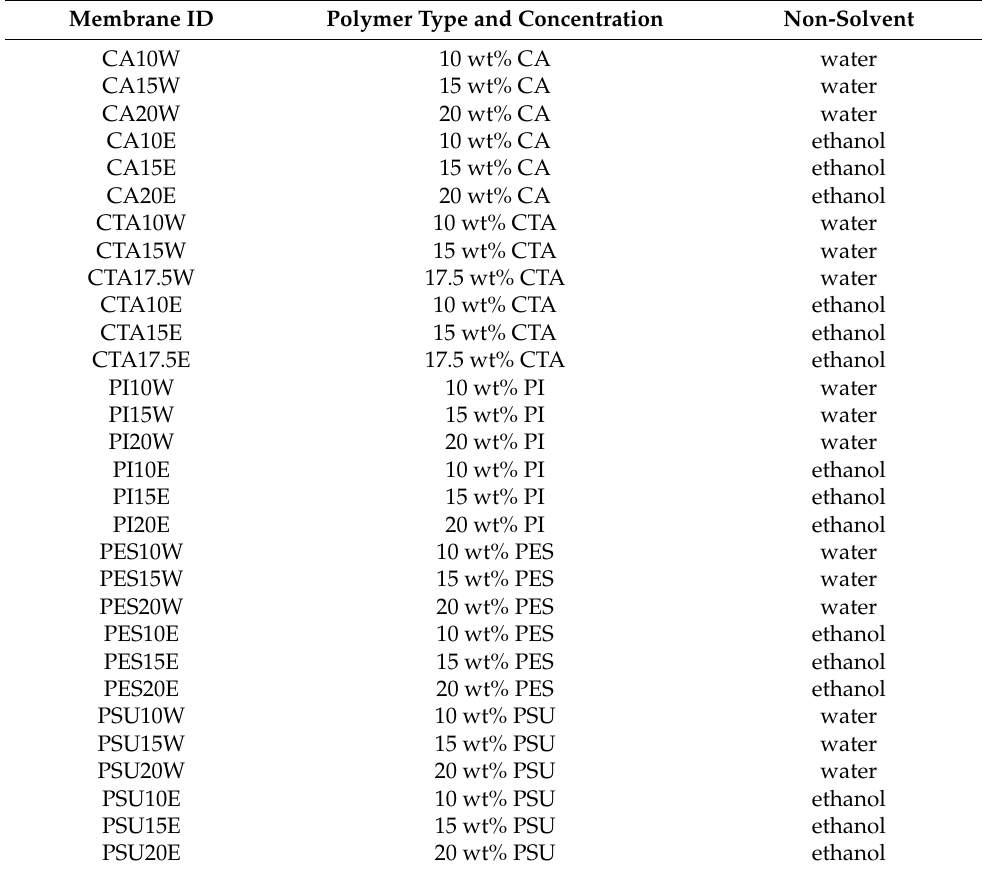
Table 2. Concentration of polymer in the casting solutions, the applied non-solvent and the membrane ID. γ -Valerolactone (GVL) was used as solvent for all membrane